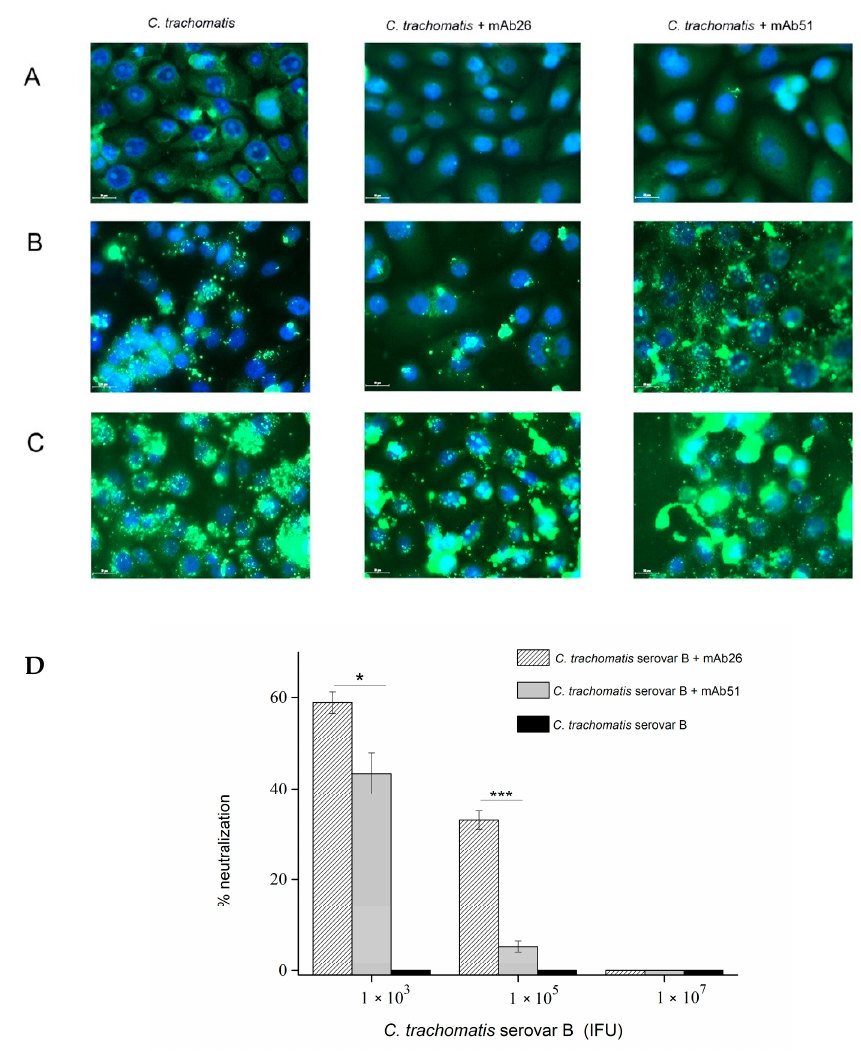
Figure 4. The in vitro potential of mAb26 and mAb51 to interfere with chlamydial infection in human conjunctival epithelial (HCjE) cells. Representative images of C. trachomatis serovar B infection of HCjE cells are presented. HCjE cells were infected with C. trachomatis serovar B elementary bodies (EBs) ( A ) 1 × 10 3 , ( B ) 1 × 10 5 , and ( C ) 1 × 10 7 infectious forming units (IFU) / well previously incubated with the mAb26 and mAb51. Percentage (%) of neutralization ( D ) was determined using the equation [(number of IFU in cells incubated without mAbs-number of IFU in cells incubated with mAbs) / number of IFU in cells incubated without mAbs] × 100. The number of inclusions was visualized by fluorescent microscopy after staining with FITC-labeled anti-chlamydial LPS Abs. Samples are assessed in triplicates, and results presented as mean ± S.E: * p < 0.05, *** p <